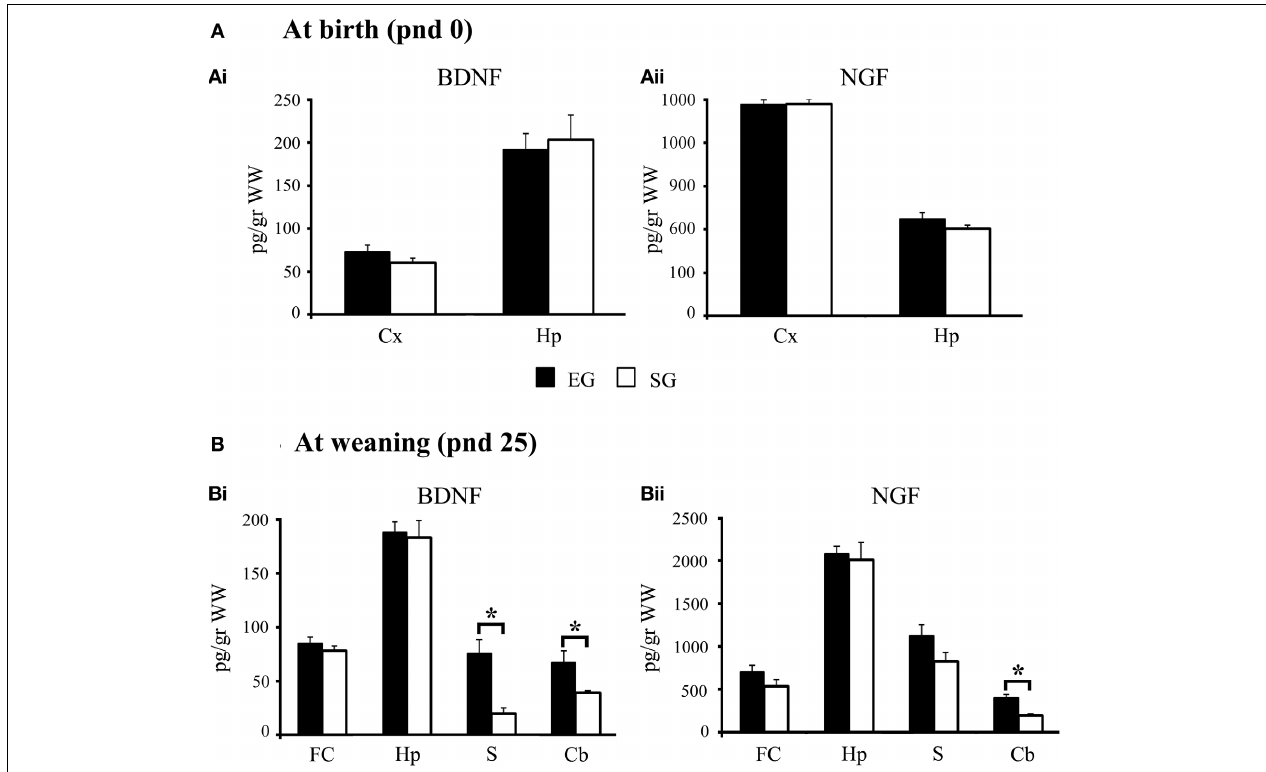
FIGURE 8 | Results of pre-reproductive maternal rearing condition on neurotrophin expression. BDNF and NGF expression levels in cortex and hippocampus at birth (Ai, Aii) ; BDNF and NGF expression levels in cortex,